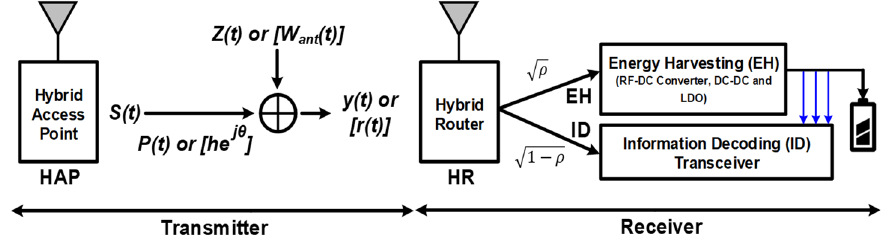
Figure 1. The concept of simultaneous wireless information and power transceiver (SWIPT).